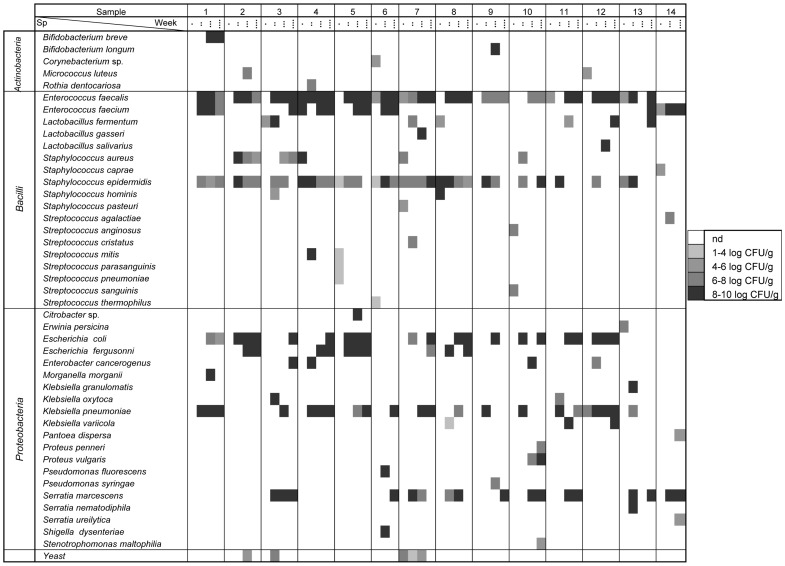
Counts of microbial species isolated and identified by species-specific PCR or 16S rRNA sequencing PCR.Forty-four different species were isolated and identified in some or all the samples analyzed (meconium (·), 1st week (··), 2nd week (···) and 3rd week (····) fecal samples). Concentrations of the identified species are represented in a grey scale from non detected (nd) in white to 8–10 log10 CFU/mL in black.